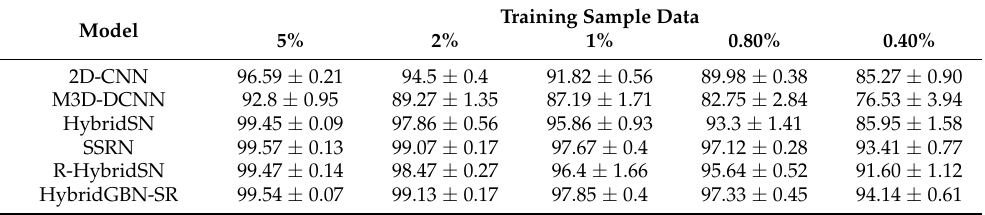
Table 8. The effect of varying the training sample data for the SSRN, Hybrid, R-HybridSN, and HybridGBN-SR models on the overall accuracy (OA) over the UP